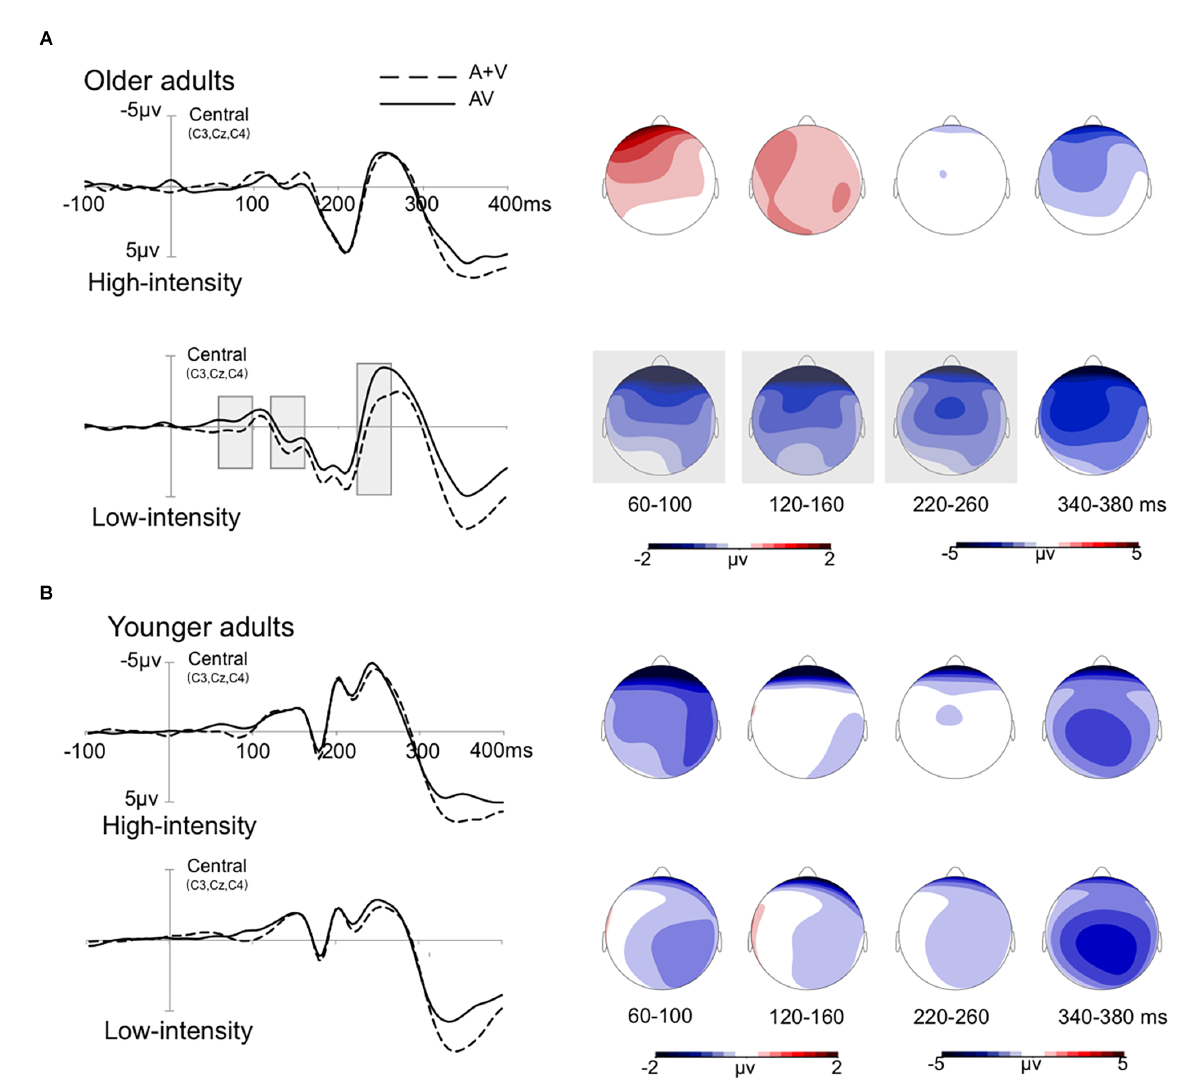
FIGURE3 Grand-averaged event-related potentials and topography map of audiovisual integration in the time window of 60–100 ms, 120–160 ms, 220–260 ms, and 340–380 ms. The wave amplitude is the average of the wave amplitudes of the three electrodes C3, Cz, and C4. The solid line is the event-related potentials of the audiovisual stimulus (AV), and the dotted line is the sum of the event-related potentials of visual and auditory stimuli (A + V). The areas where audiovisual integration increases are marked with gray squares. The topographic map shows the difference between AV and A + V. (A) The amplitude of waves in older adults under high- and low-intensity conditions. (B) The amplitude of waves in the younger adults under high- and low-intensity